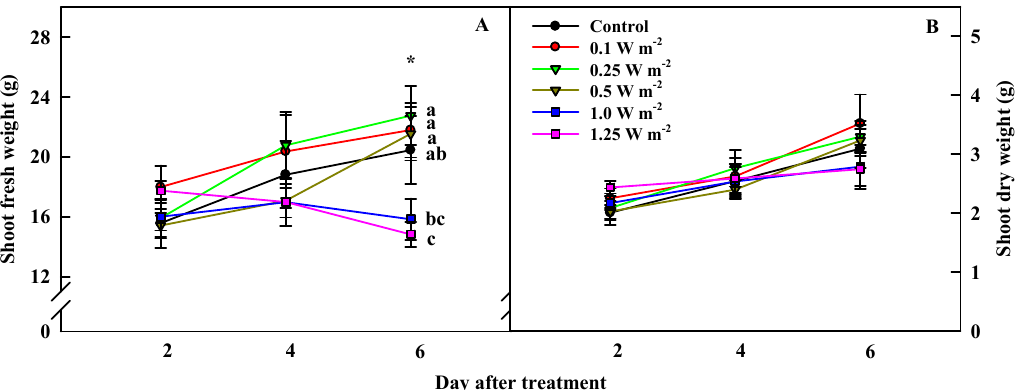
Figure 1. Shoot fresh ( A ) and dry ( B ) weights of C. denticulatum subjected to five energy levels of UV-B radiation for 6 days. The UV-B treatments started after 5 weeks of transplanting. Different letters next to bars indicate a significant difference by Duncan’s multiple range test at p < 0.05 ( n = 12).